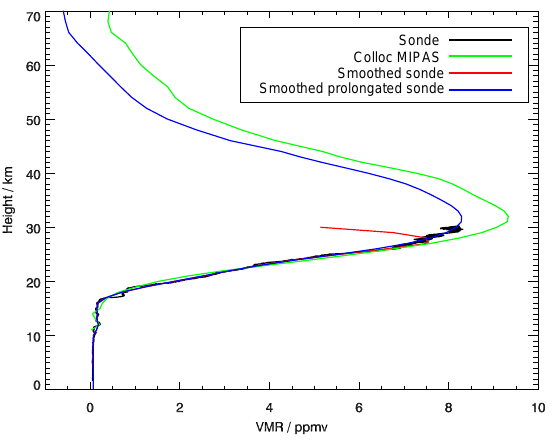
Figure 6. Biases with respect to Boulder (39.99 ◦ N) and Hilo (19.72 ◦ N) ozonesondes for the old (V5R) and new (V7R) MIPAS data versions. The altitudes at which the bias is significant at the 2 σ level are highlighted by circles.